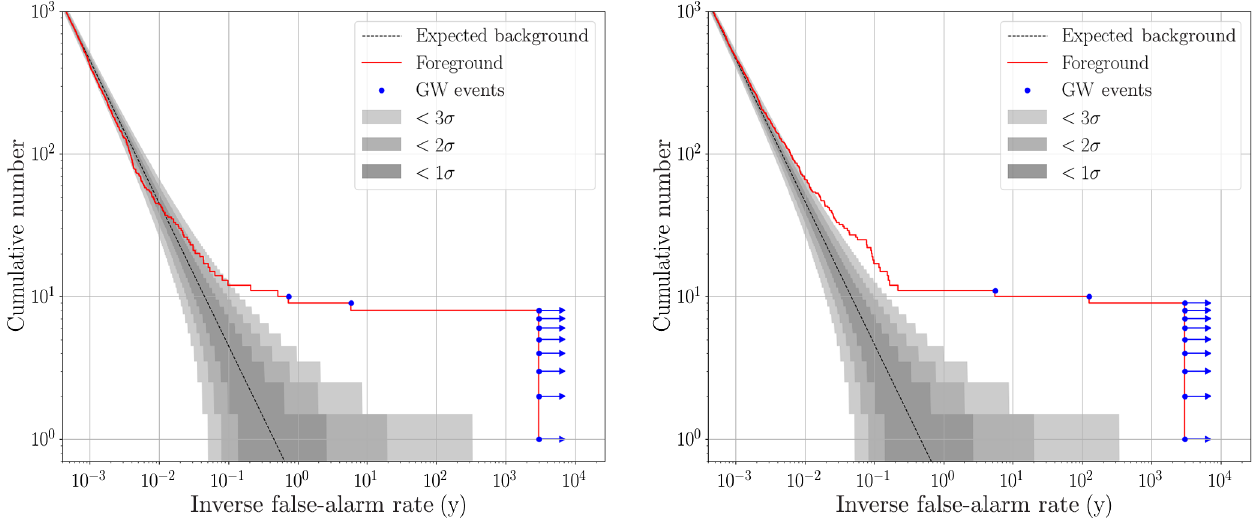
FIG. 2. Cumulative histograms of search results for the matched-filter searches, plotted versus inverse false-alarm rate. The dashed lines show the expected background, given the analysis time. Shaded regions denote sigma uncertainty bounds for Poisson uncertainty. The blue dots are the named gravitational-wave events found by each respective search. Any events with a measured or bounded inverse false-alarm rate greater than 3000 y are shown with an arrow pointing right. Left: PyCBC results. Right: GstLAL